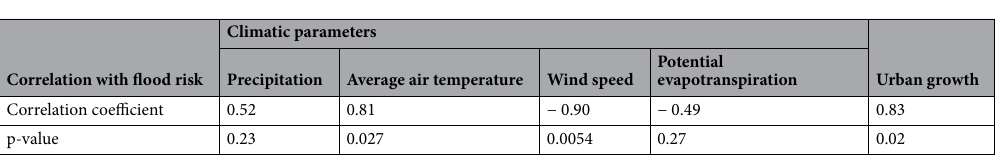
Correlation with flood